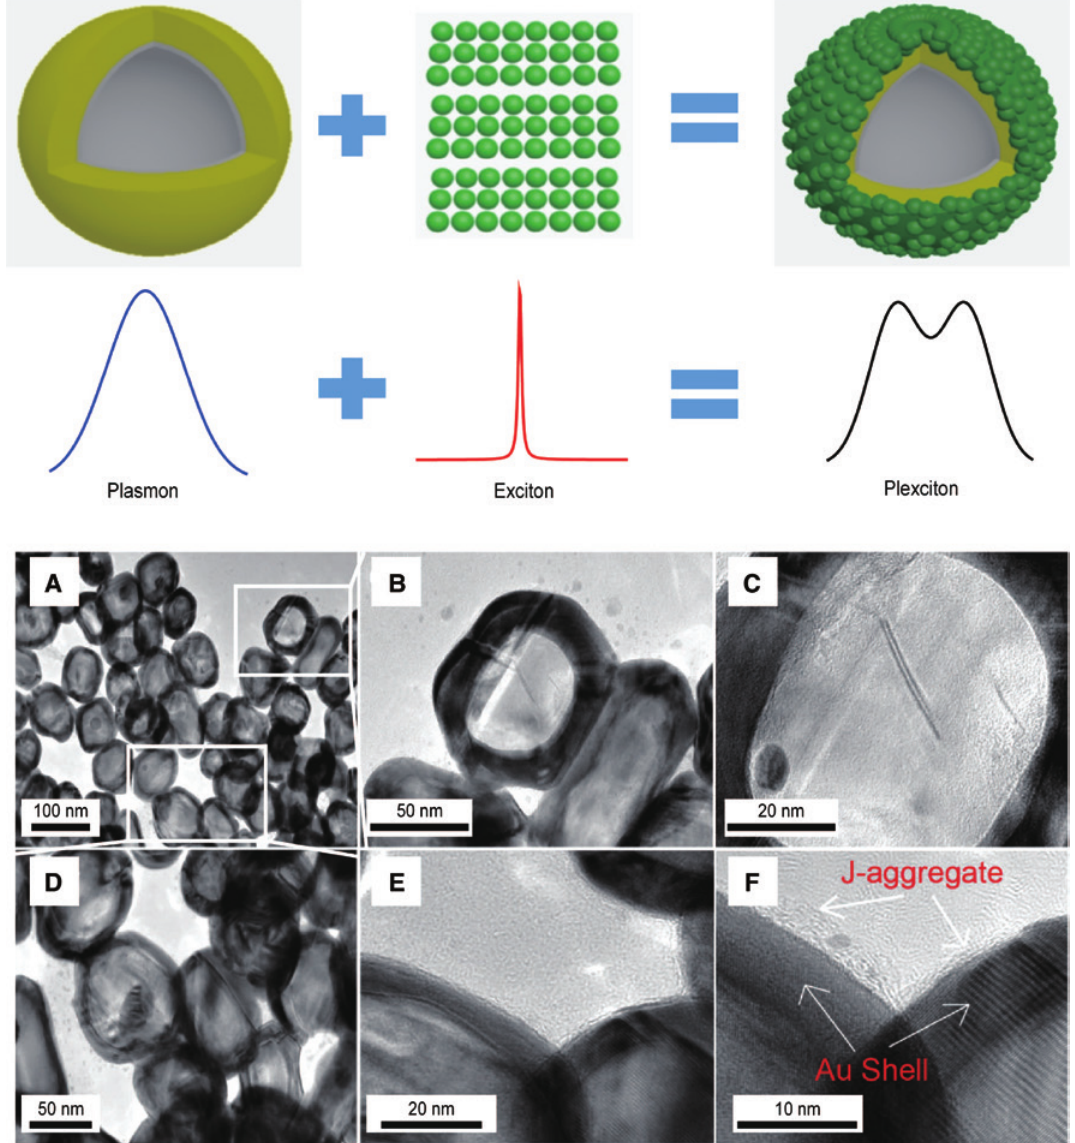
Figure 1: Above, schematic diagram of the hybrid and related Rabi-splitting of an Ag@Au hollow nanoshell embedded in an ensemble of J-aggregate [the pristine monomer molecule is 1,1 ′ -diethyl-2,2 ′ -cyanine iodide ( Cy + )]. Below, TEM images of the Ag@Au hollow nanoshell-J-aggregate plexciton system at different magnifications, which corresponds to curves j in Figure 2B, are shown below. The corresponding LSP peak of the bare Ag@Au HNS is at 661 nm. The average diameter of the bare Ag@ Au HNS is 80 nm; the diameter of the inner hollow cavity is 60 nm. (A) TEM images of the Ag@Au hollow nanoshell-J-aggregate plexciton system with scale bar 100 nm; (B) and (C) are enlargement of rectangle part shown in (A) with scale bars as 50 nm, 20 nm respectively; (D) and (E), (F) are enlargement of another rectangle part shown in (A) with scale bars as 50 nm, 20 nm, 10 nm respectively; Especially, J-aggregate and Au shell are clearly distinguished in